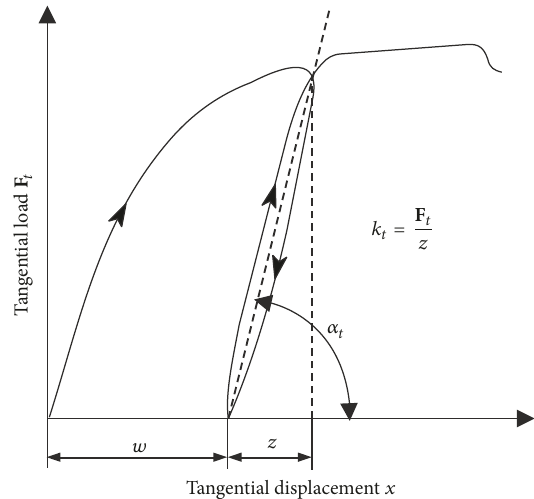
Figure 9: Elastic predisplacement between contact surfaces [24].